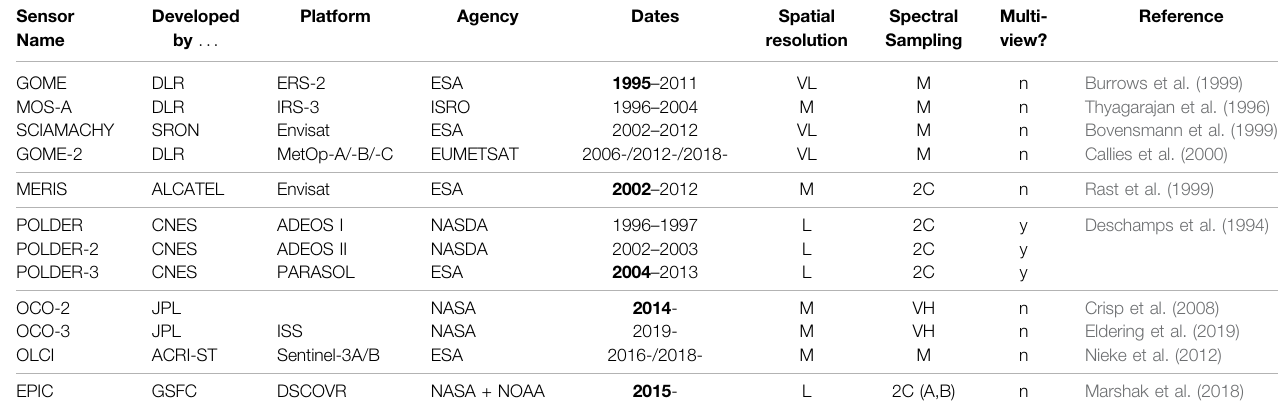
TABLE 1| CompendiumofsatellitemissionswithDOAScapabilityorderedchronologicallyandclusteringsensorswithsimilar characteristics.Tothebestofourknowledge, SCIAMACHY is the fi rst instrument with an operational DO 2 AS-based cloud product (Kokhanovsky et al., 2005), followed by the POLDER series (Buriez et al., 1997; Vanbauce et al., 1998) and EPIC (Yang et al., 2019). Research cloud property retrievals have been developed for these missions, e.g., MOS-A (Preusker et al., 2007), POLDER-3 (Ferlay et al., 2010), and others, most recently, OCO-2/3 (Richardson et al., 2017; Richardson and Stephens, 2018; Richardson et al., 2019; Richardson et al., 2020). Such experimental retrievals can and have been transitioned into fully operational elements in the data processing